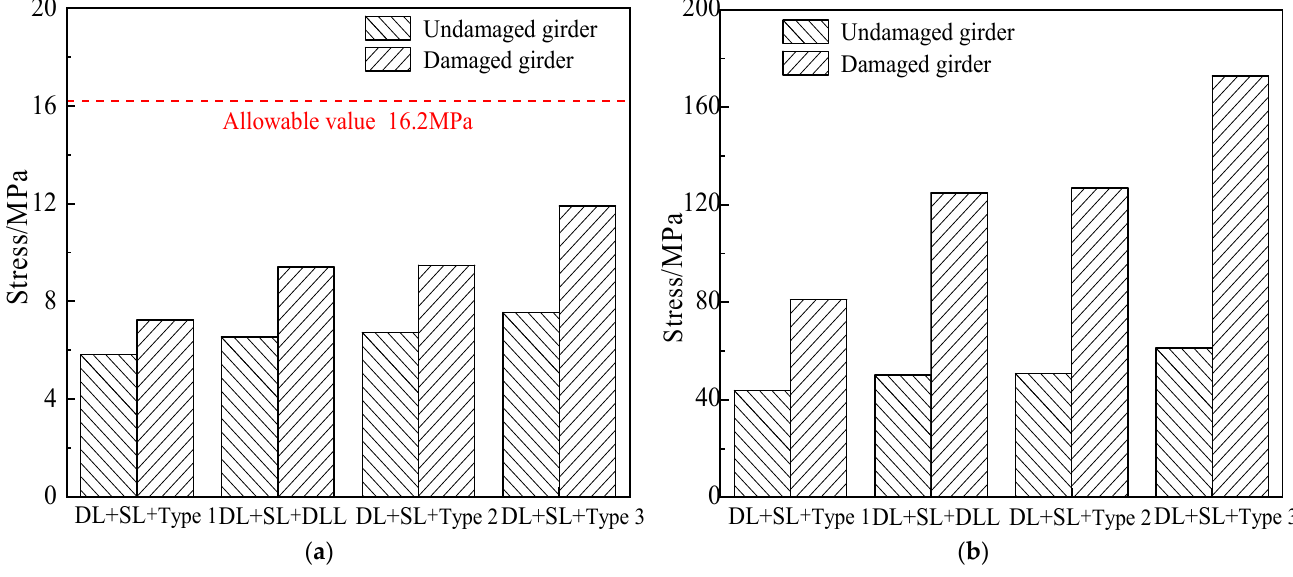
Figure 24. Stress comparison due to the destructive tests ( a ) Stress of concrete; ( b ) Stress of longitudinal steel bars.